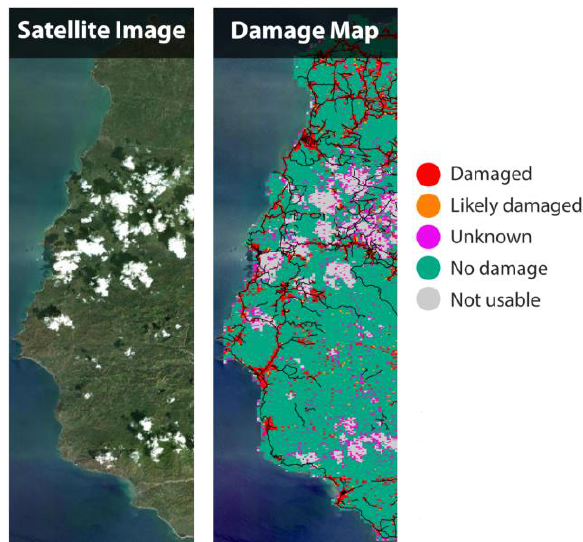
Figure 4. Results of the post-disaster building damage assessment. Left: Digital Globe (WorldView 3) satellite image of the area affected for 10 October 2016. Right: Result of post- disaster damage assessment using Picture Pile